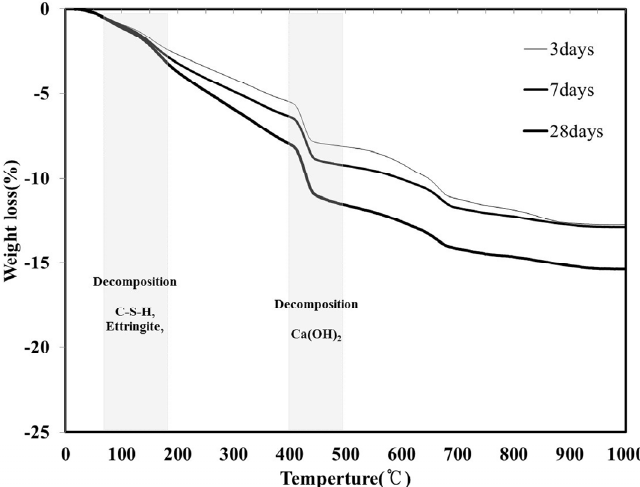
Figure 7. Thermogravimetric analysis (TGA) curve of the LH100 specimen at 3, 7 and 28 days.